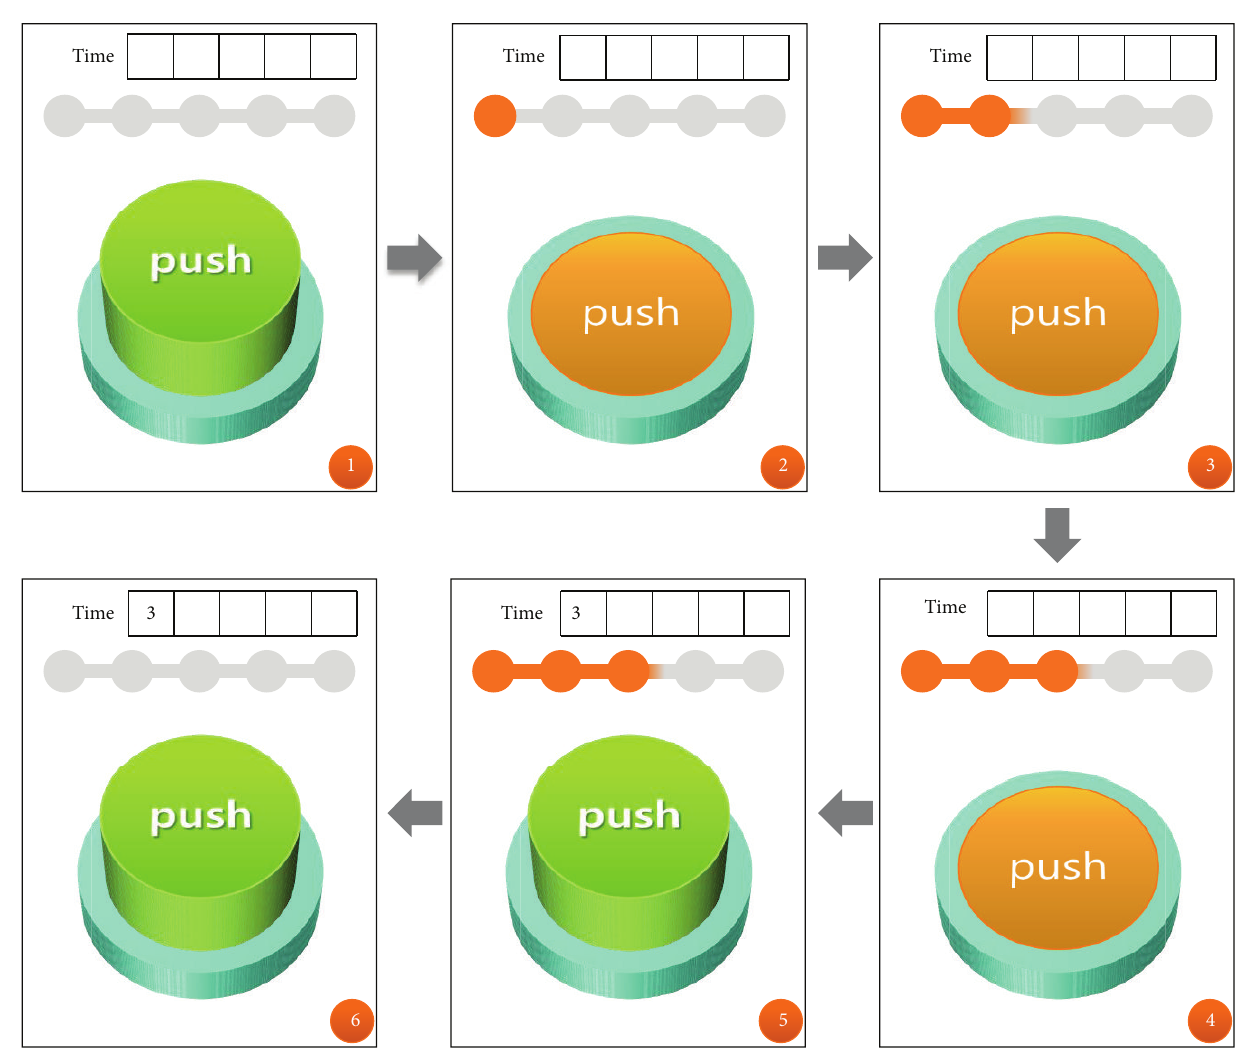
Figure 1: The time pattern input procedure of